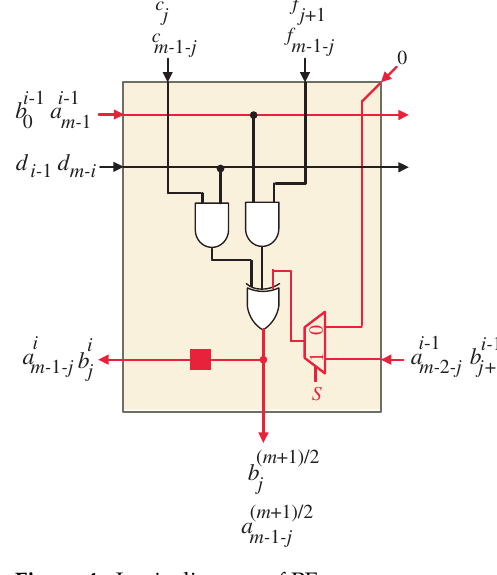
Figure 4. Logic diagram of PE j .